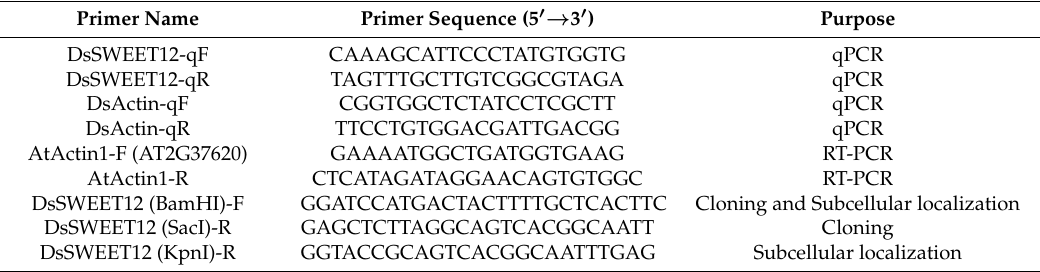
Table 1. List of primers used in this